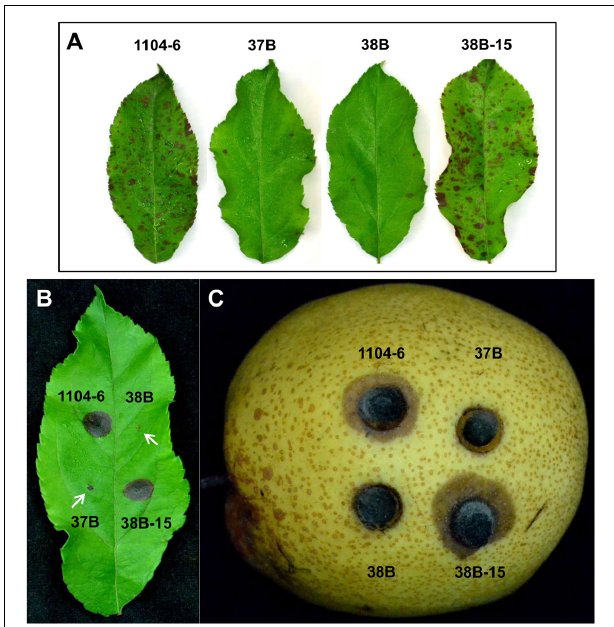
FIGURE 5 | The CfPMK1 gene is required for pathogenicity. (A) Disease symptoms on detached apple leaves (Gala variety) inoculated with conidial suspensions (10 6 /mL) of different strains. Typical leaves were photographed at 5 dpi. (B) Disease symptoms on pre-wounded apple leaves (Gala variety) inoculated with mycelial plugs of different strains. Typical leaves were photographed at 3 dpi, arrowheads mark the wound sites for 37B and 38B strains, mycelial plugs were removed away prior to photographing. (C) Disease symptom of pre-wounded pear fruit inoculated with mycelial plugs of different strains. Typical leaves were photographed at 2